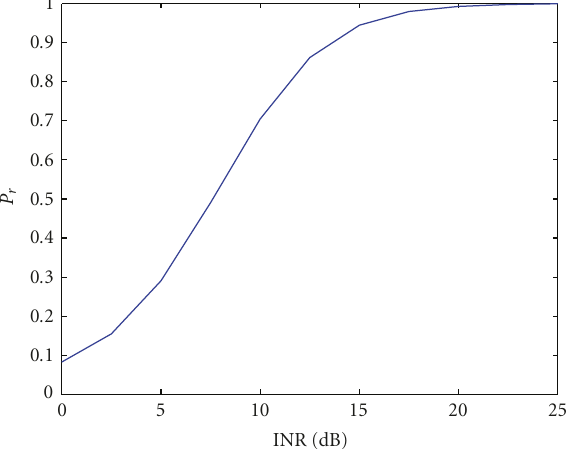
Figure 12: P r versus INR. Data from file 19980204 − 220849, with N = 8, K = 24, N it = 1, and P e